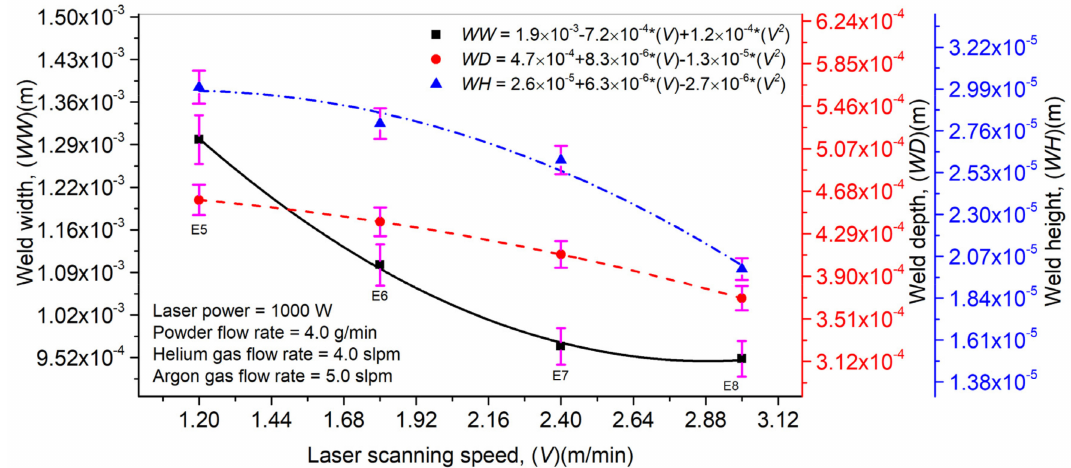
Figure 10. Effect of laser scanning speed on laser weld width, depth, and height in laser welding with filler material (Inconel 718).